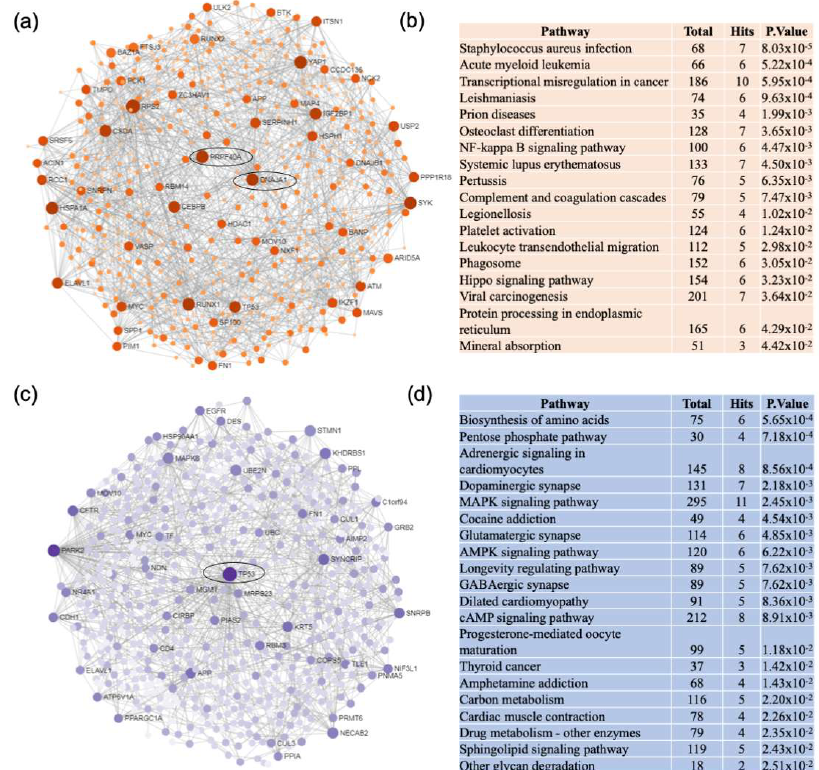
Figure 4. Network and pathway analyses of dysregulated genes in the frontal cortex of VaD patients. Network and pathway were performed on the dataset from VaD patients compared to non-demented controls to identify unique dysregulated pathways in the frontal cortex of VaD. Network and pathway analyses were performed using NetworkAnalyst. Tissue specific networks derived from the protein-protein interaction database from brain frontal cortex were selected. The minimum connected network was analyzed further. Results from the pathway analysis are derived from the Kyoto Encyclopedia of Genes and Genome (KEGG). ( a ) Upregulated genes are shown in orange. Most significant hubs according to degree and betweenness centrality, with the highest number of connections, are enclosed in ovals. ( b ) The 20 top dysregulated pathways ranked according the p-value of significance are presented in the table. Totals refers to the total number of genes that are known to be involved in the KEGG pathway and hits refers to the number of genes identified in this analysis that are involved in the pathway. ( c ) Downregulated genes are shown in blue. Most significant hubs according to degree and betweenness centrality, with the highest number of connections, are enclosed in ovals. ( d ) The 20 top dysregulated pathways ranked according the p-value of significance are presented in the table.